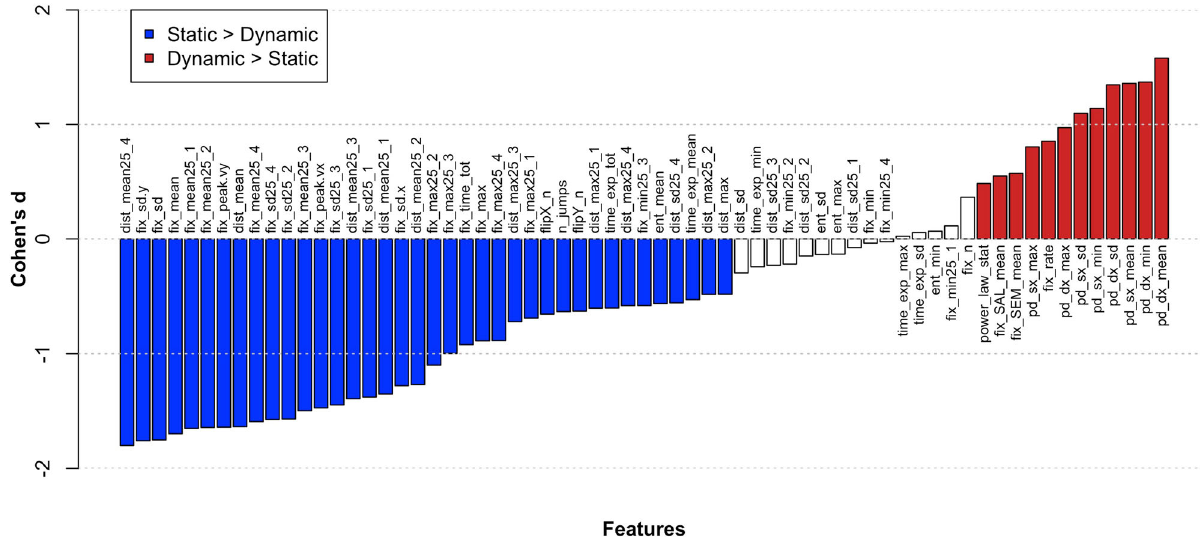
Fig. 4 Characterization of the static vs. dynamic viewing styles. A series of t-test was run comparing Static ( n = 42) and Dynamic ( n = 72) Viewers across all features. Supplementary Table 2 shows a description of features ’ labels. In order for the different metrics to be comparable, an effect-size measure (i.e., Cohen ’ s d) has been computed ( Y -axis). Signi fi cant results surviving false discovery rate (FDR) correction for multiple comparisons are represented by coloured bars. Red bars indicate a signi fi cantly higher value for Dynamic viewers compared to Static viewers in the corresponding feature, while blue bars reveal the opposite pattern (i.e., Static viewers higher than Dynamic). White bars indicate t-tests not reaching signi fi cance after FDR